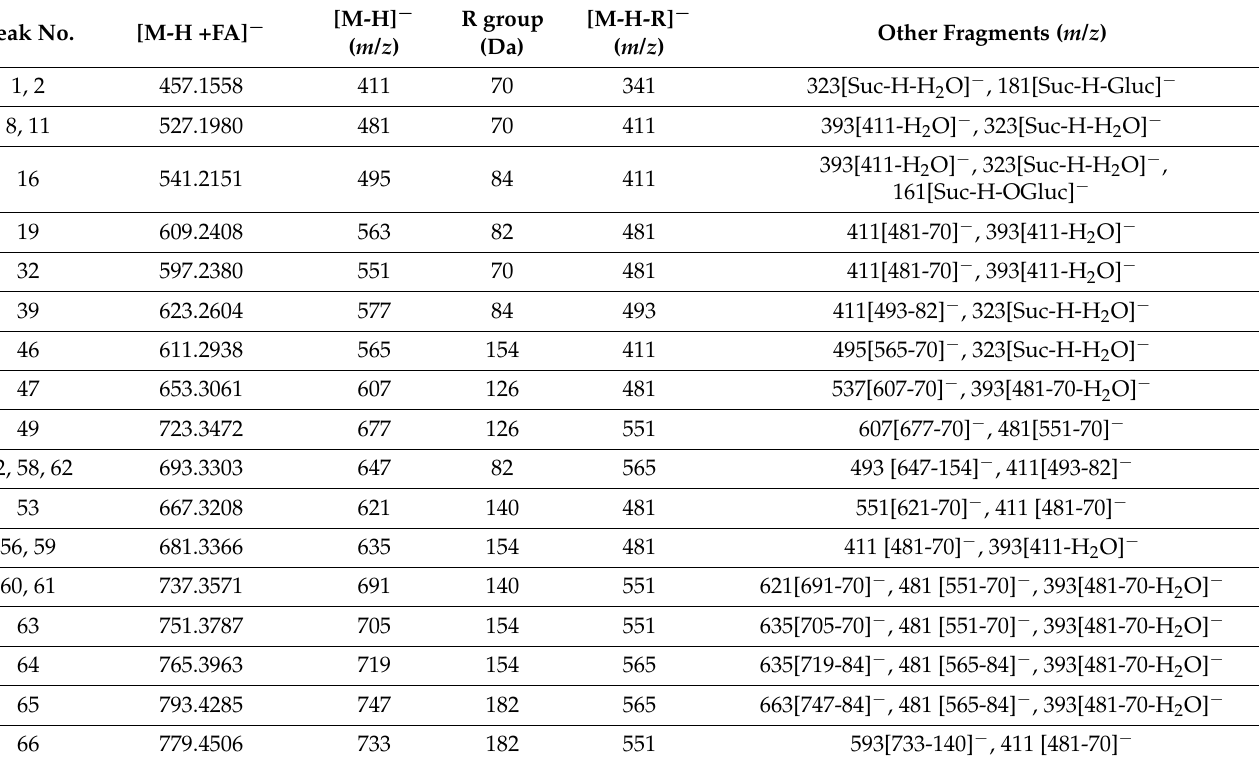
Table 2 summarizes the characteristic formic acid adduct [M-H+FA] − for these com- pounds and the fragmentation pattern consisting of the [M-H] − ion and the initial loss of one R group, such as isobutanoyl (C 4 H 6 O, 70 Da), pentenoyl (C 5 H 6 O, 82 Da), 2-metylbutanoyl (C 5 H 8 O, 84 Da), octanoyl (C 8 H 14 O, 126 Da), nonanoyl (C 9 H 16 O, 140 Da), decanoyl (C 10 H 18 O, 154 Da) and dodecanoyl (C 12 H 22 O, 182 Da), while other observed fragments corresponded to the loss of other R groups or water [26]. Table 2. UPLC-ESI-MS characterization of sucrose esters in P. peruviana samples from Costa Rica. Peak No.